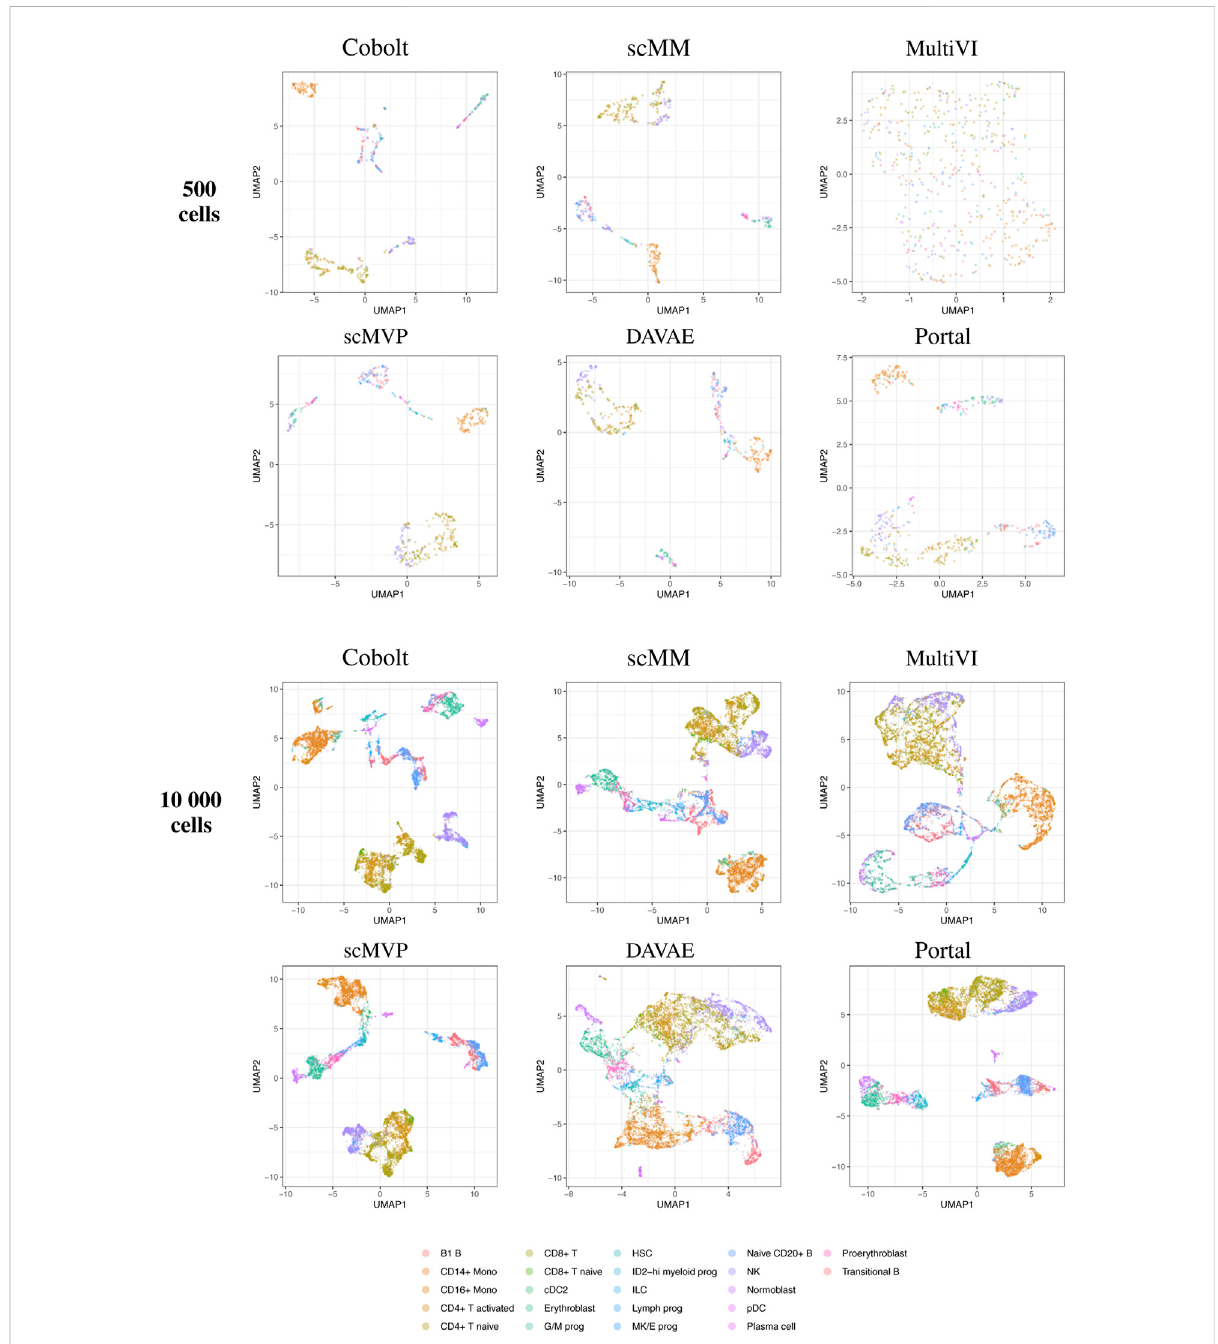
FIGURE 4 UMAP of the 10-dimensional latent space of Cobolt, scMM, MultiVI, scMVP, DAVAE, and Portal based on 500 (top) and 10,000 (bottom) cells of one exemplary subsample from the Multiome dataset each. The color coding corresponds to manually annotated cell types as provided by Luecken et al.